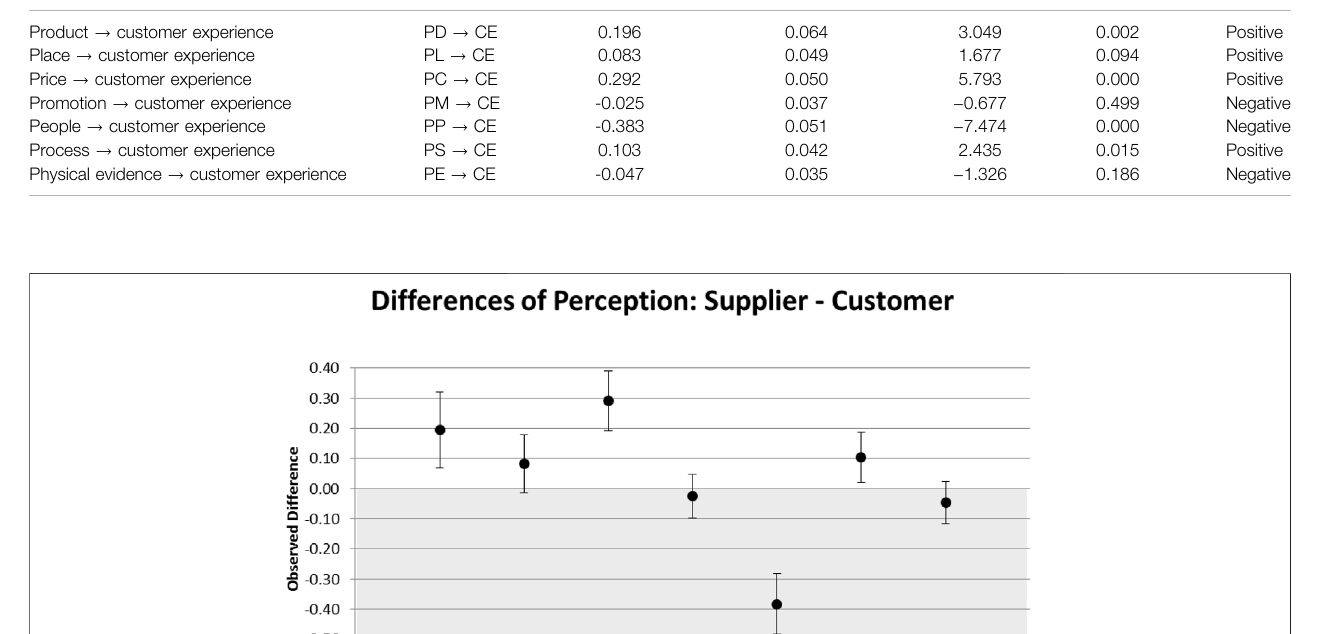
TABLE 12 | Comparison of supplier – customer. Supplier — customer